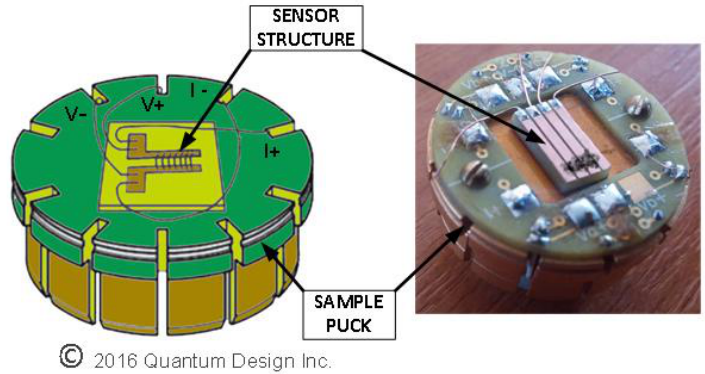
Figure 1: Sensor connection to perform a four-wire resistance measurement Figure 2. Device under test (DUT)—Four point connection to measure resistance.